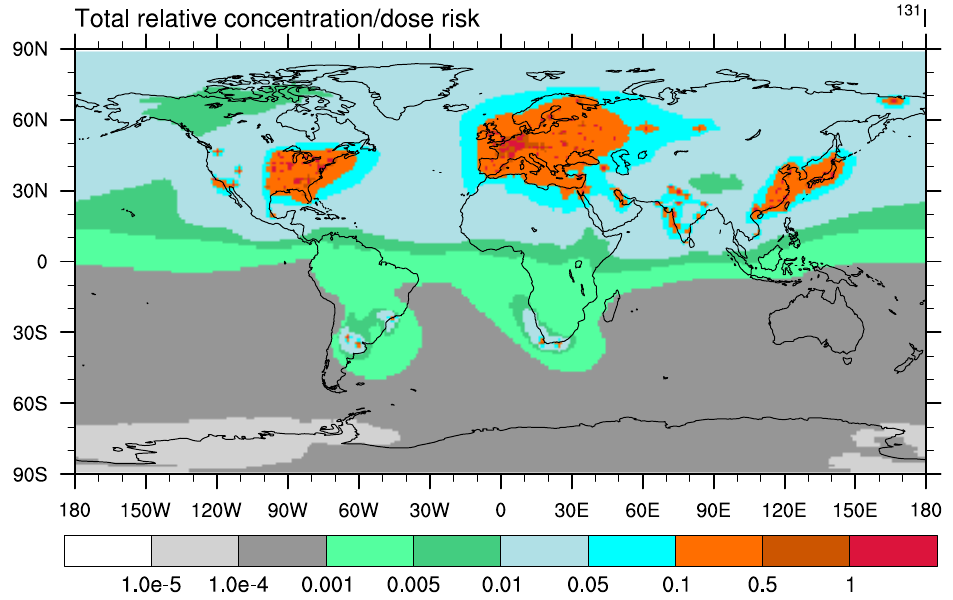
Figure 3. Combined total (operating, under construction, planned or proposed) relative risk by 131 I and equivalent daily effective dose to the public from inhalation over the 2010–2030 period; after